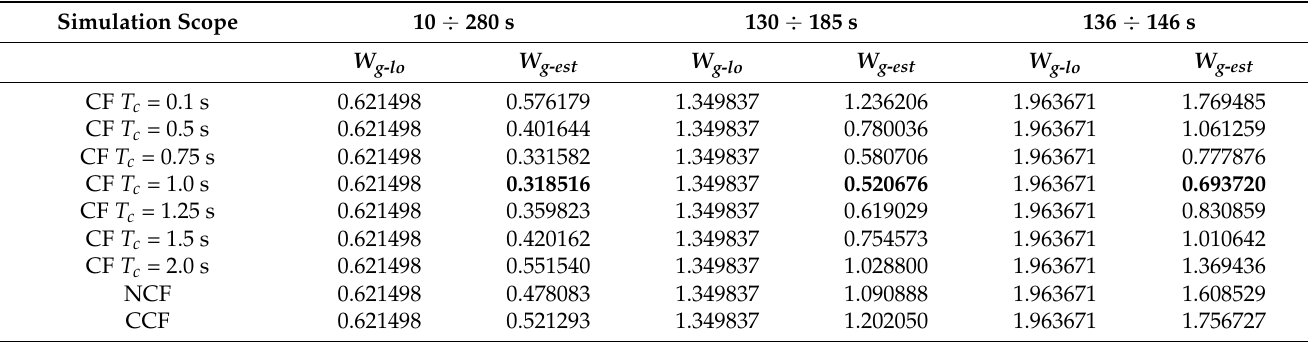
Table 2. The results of computation of performance indices for delay = 1 s.